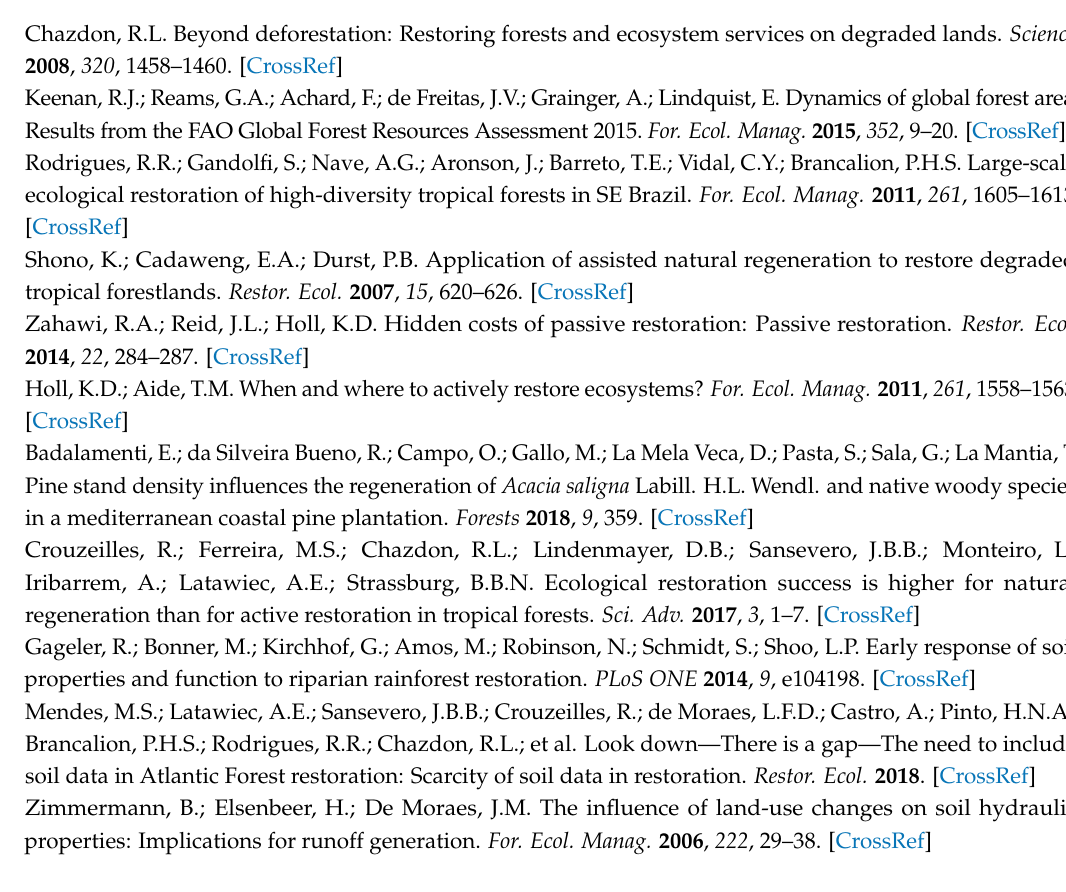
Figure S1: Correlogram showing the Pearson correlations coefficients between soil attributes across the study sites: Reference Forest, Assisted Passive Restoration, Active Restoration, Low-intensity Pasture and High-intensity Pasture. Table S1: List of species used in the Active Restoration site. Table S2: Species list of the trees with DBH > 5 cm sampled in the studies sites: Reference Forest, Assisted Passive Restoration and Active Restoration. Table S3: Species list of the trees with DBH 1–5 cm sampled in the studies sites: Reference Forest, Assisted Passive Restoration and Active Restoration. Table S4: Vegetation attributes across the study plots. Table S5: Mean for soil attributes in the depth 0–5 cm across the study